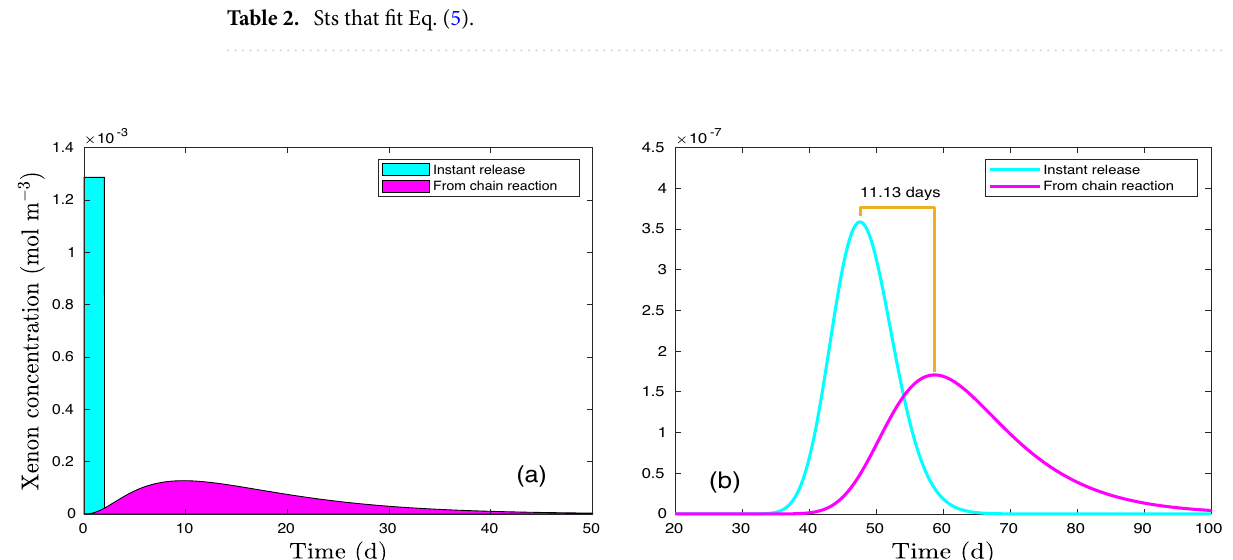
Figure 5. Xenon signatures are delayed by radionuclide decay. ( a ) Xenon concentration in the source area. ( b ) Xenon concentration 100 m away from source area with a flow velocity of 2 [m d − 2 1 [m d −